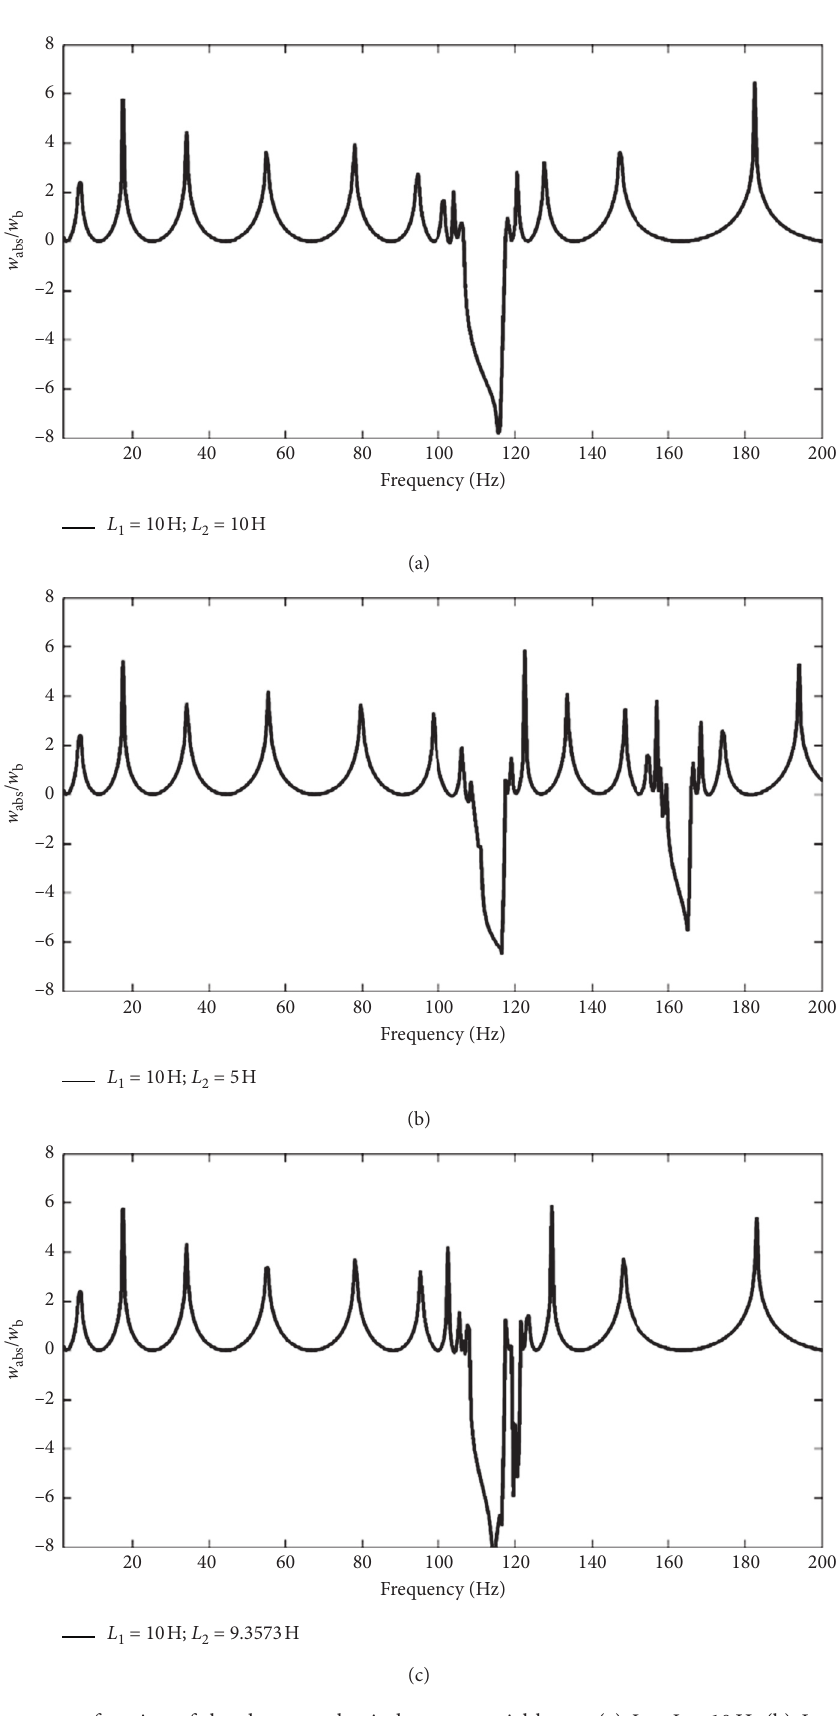
� L � 10H; (b) L � 10H and L � 5H; 1 2 1 2